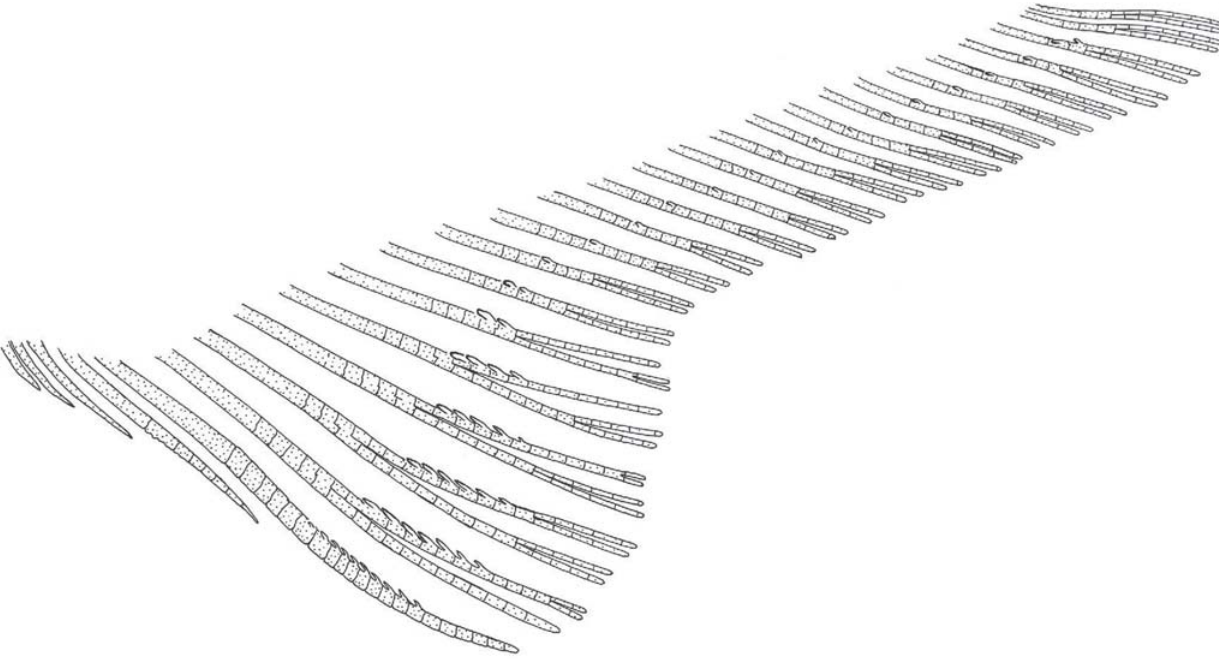
Fig. 16. Glandulocauda melanopleura , adult male, USNM 236415, 42.6 mm SL; anal-fin rays, lateral view, left